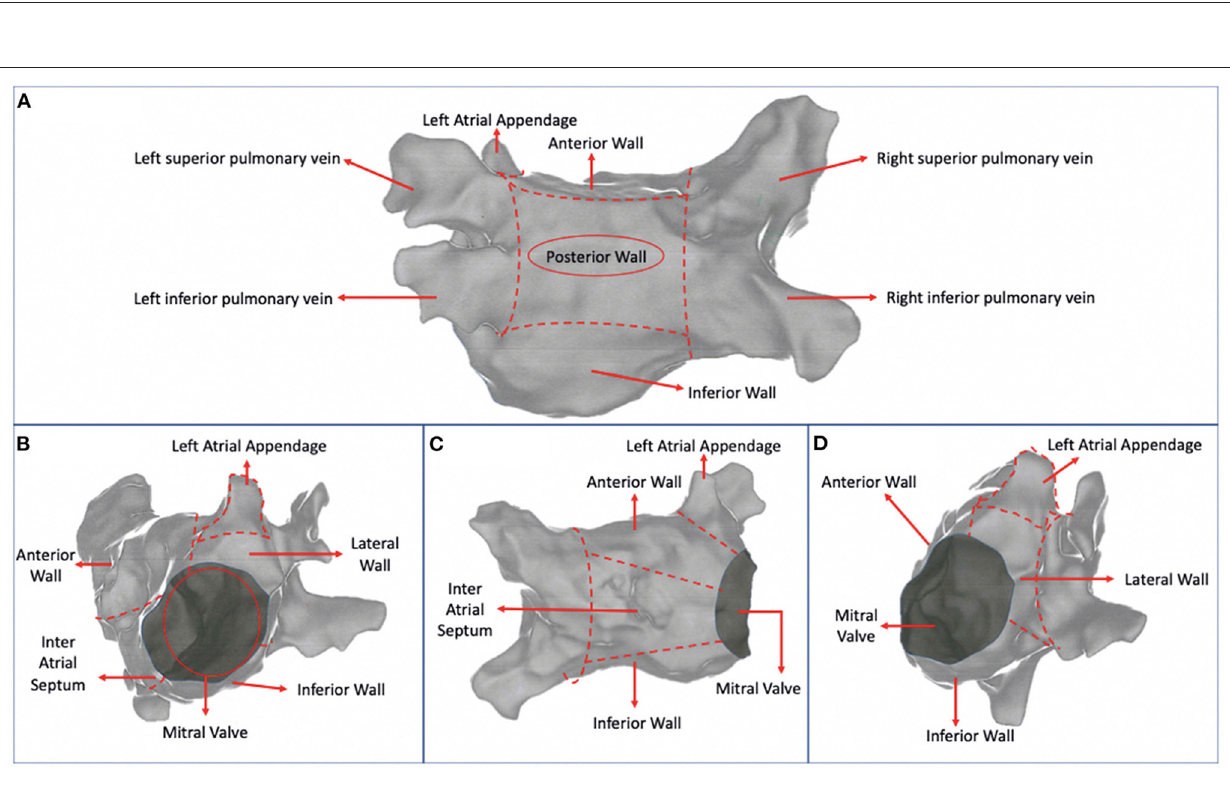
FIGURE 2 | Additional ablation